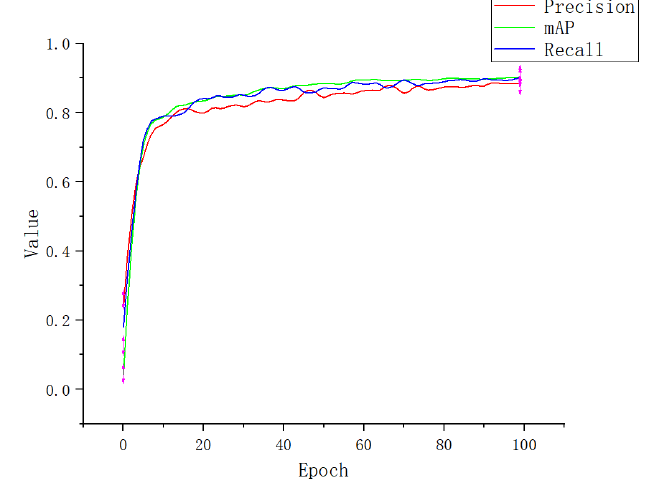
Figure 12. Performance index curve of SE.